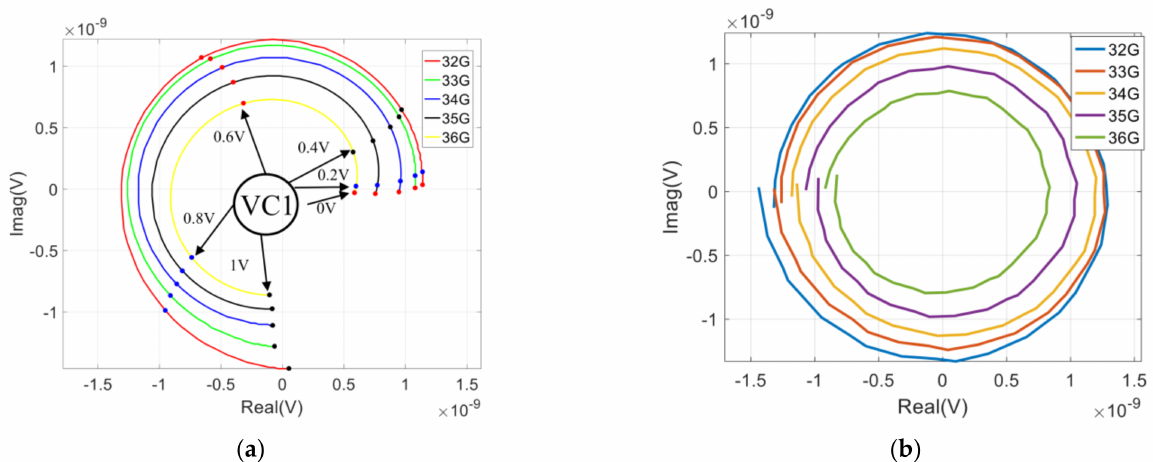
Figure 17. The simulation of the correlation circle: ( a ) The control voltage of only one phase shifter (VC1) varies; ( b ) The control voltage of both phase shifters